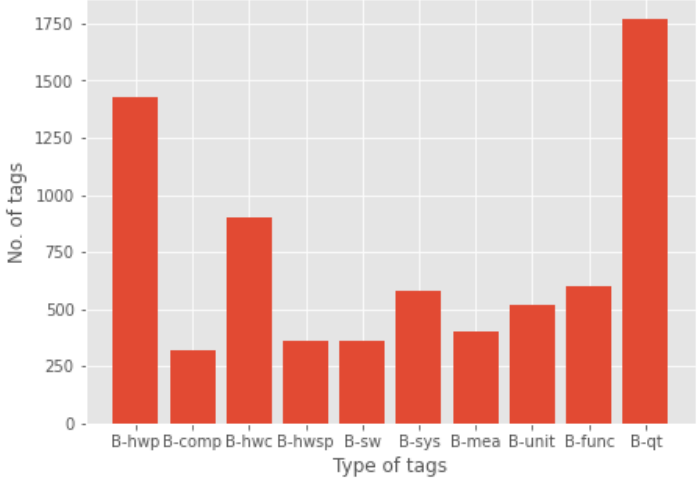
Figure 5. Distribution of class